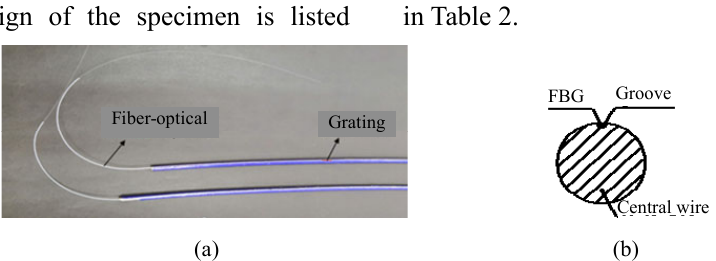
Fig. 1 Schematic diagram of the test piece: (a) embedded preloading process and (b) cross-section diagram of the central wire. Table 2 Experimental